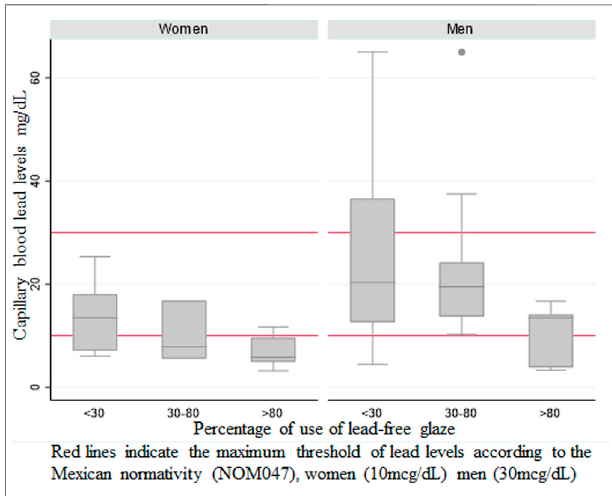
FIGURE 2 | Capillary blood lead levels (mcg/dl) by sex and according to the declared percentage of use of lead-free glaze.